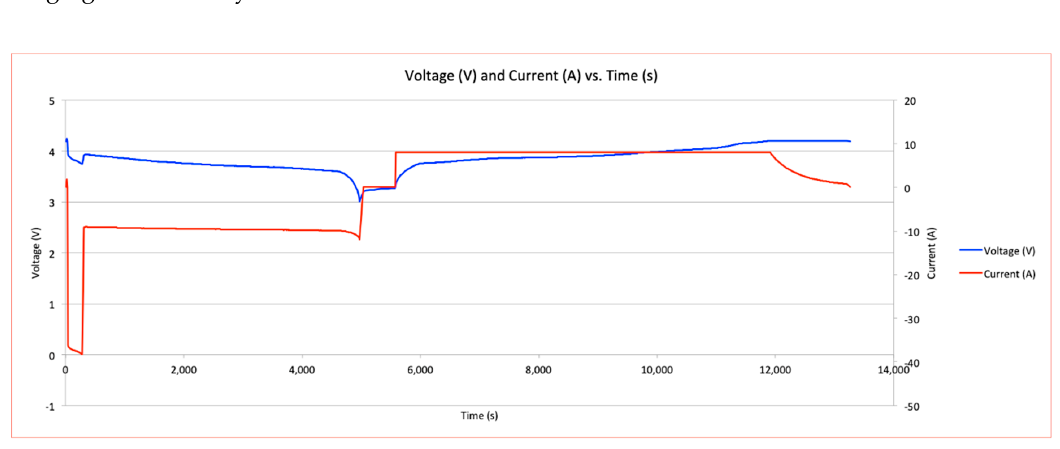
Figure 17. Battery individual cell testing under flight load profile: Voltage and current vs. time.